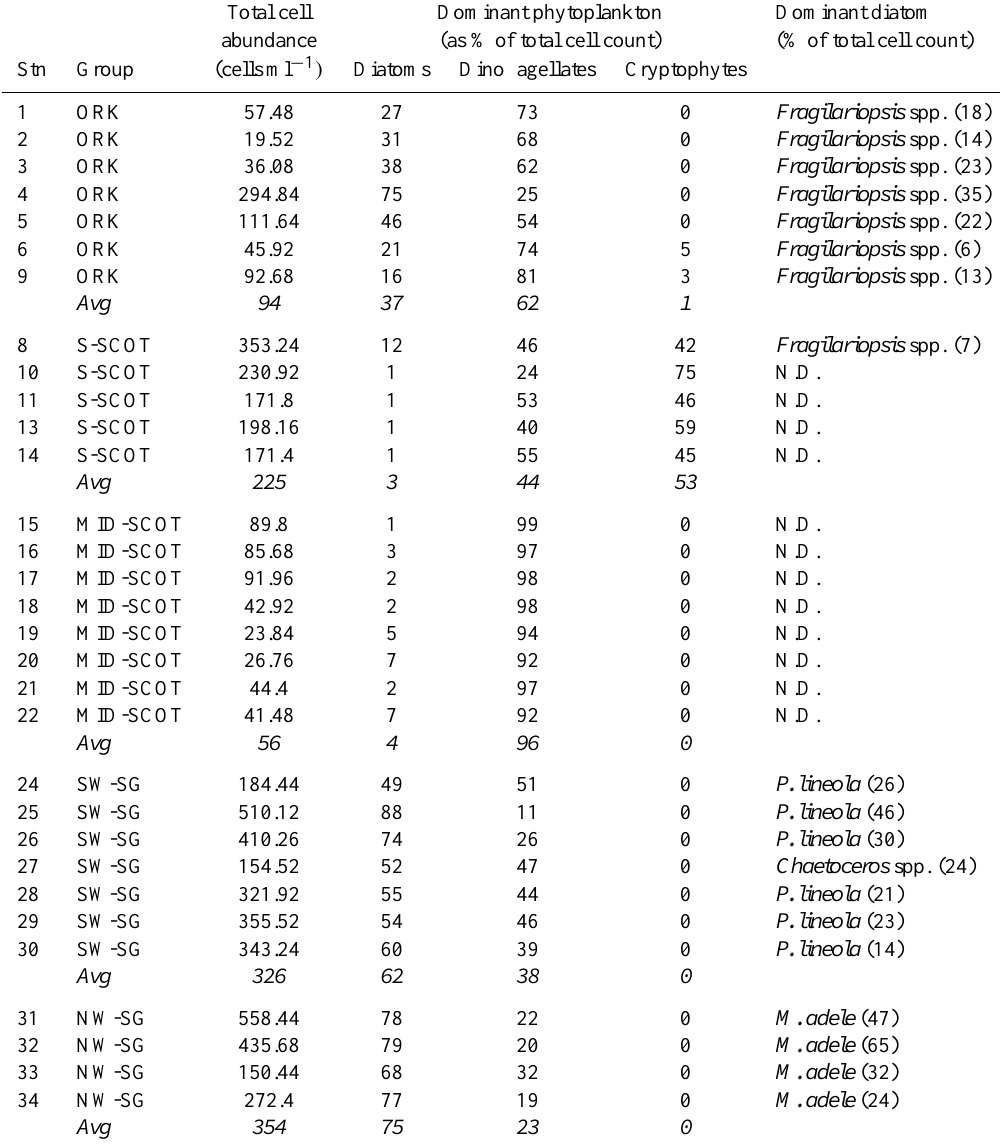
Table 1. Community composition of the 2008 summer stations (cell abundance), N.D. indicates no dominant